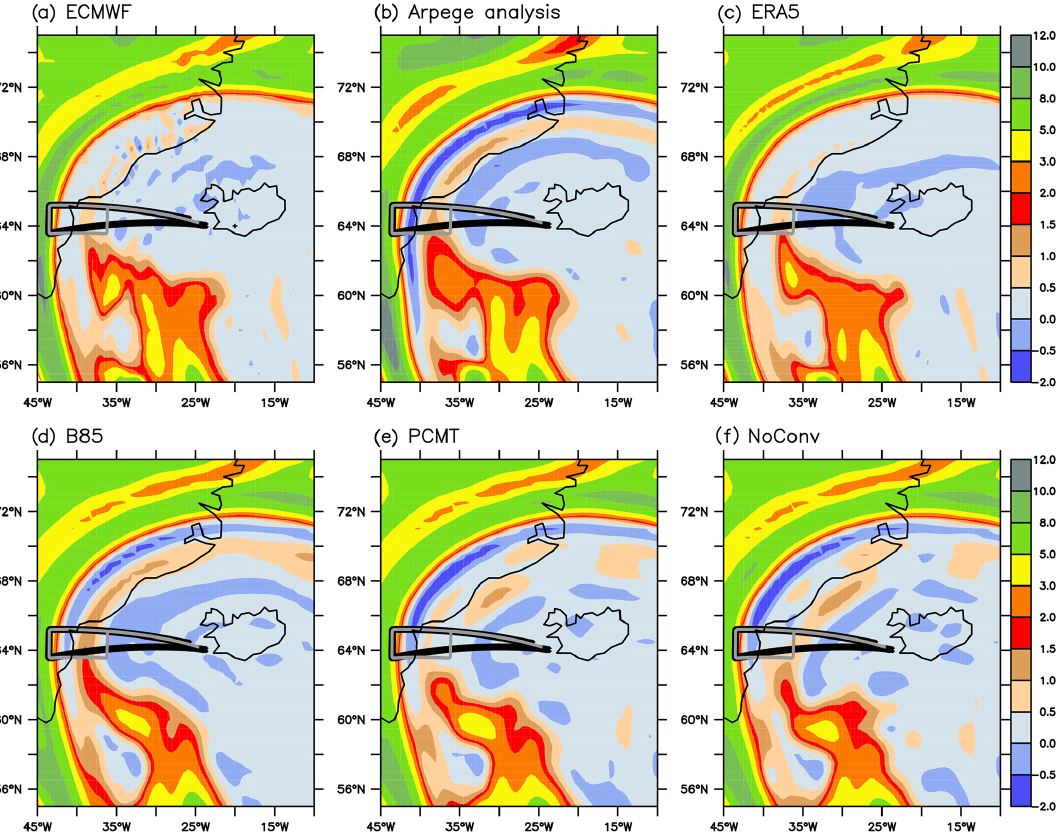
Figure 8. Potential vorticity (units: PVU) at 300hPa at 12:00UTC on 2 October for the (a) ECMWF-IFS operational analysis, (b) ARPEGE operational analysis, (c) ERA5 reanalysis, (d) B85 run, (e) PCMT run and (f) NoConv run. The black and grey lines correspond to the SAFIRE and DLR Falcon flights that occurred between 09:00 and 12:00UTC on 2 October in an anticlockwise